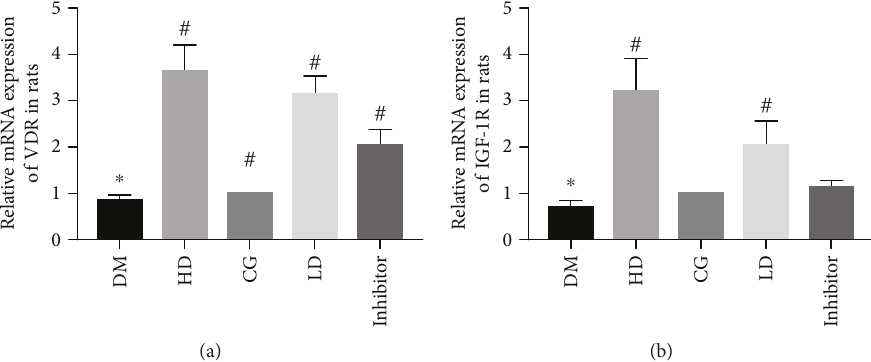
Figure 3: Expression of VDR and IGF-1R mRNA in rat testicles in each group. The RT-PCR results showed that the mRNA levels of VDR and IGF-1R in the DM group were signi fi cantly lower than those in the CG group ( p < 0 05 ). The expression levels of VDR and IGF-1R in the HD and LD groups were signi fi cantly higher than that in the DM group ( p < 0 05 ). The expression of IGF-1R in the LD group was signi fi cantly higher than that in the DM group ( p < 0 05 ). The expression of IGF-1R in the inhibitor group was signi fi cantly lower than that in the HD group. ∗ Compared with the CG group, p < 0 05 ; # compared with the DM group, p < 0 05